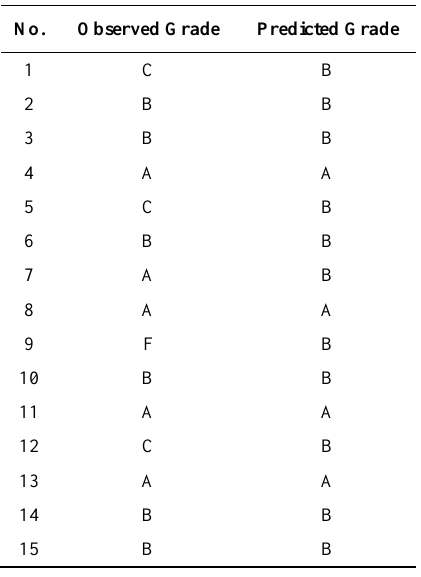
Table 2. Observed vs. predicted